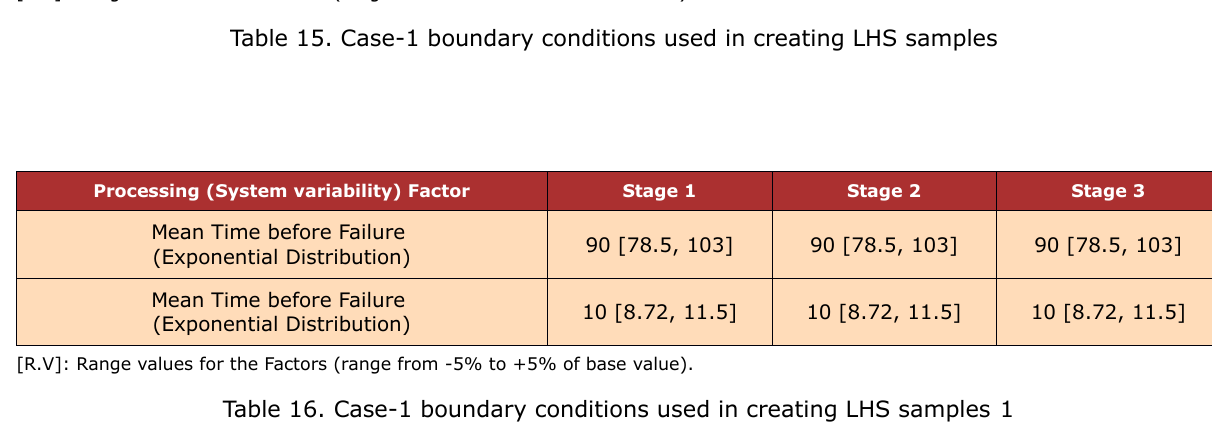
Table 16. Case-1 boundary conditions used in creating LHS samples